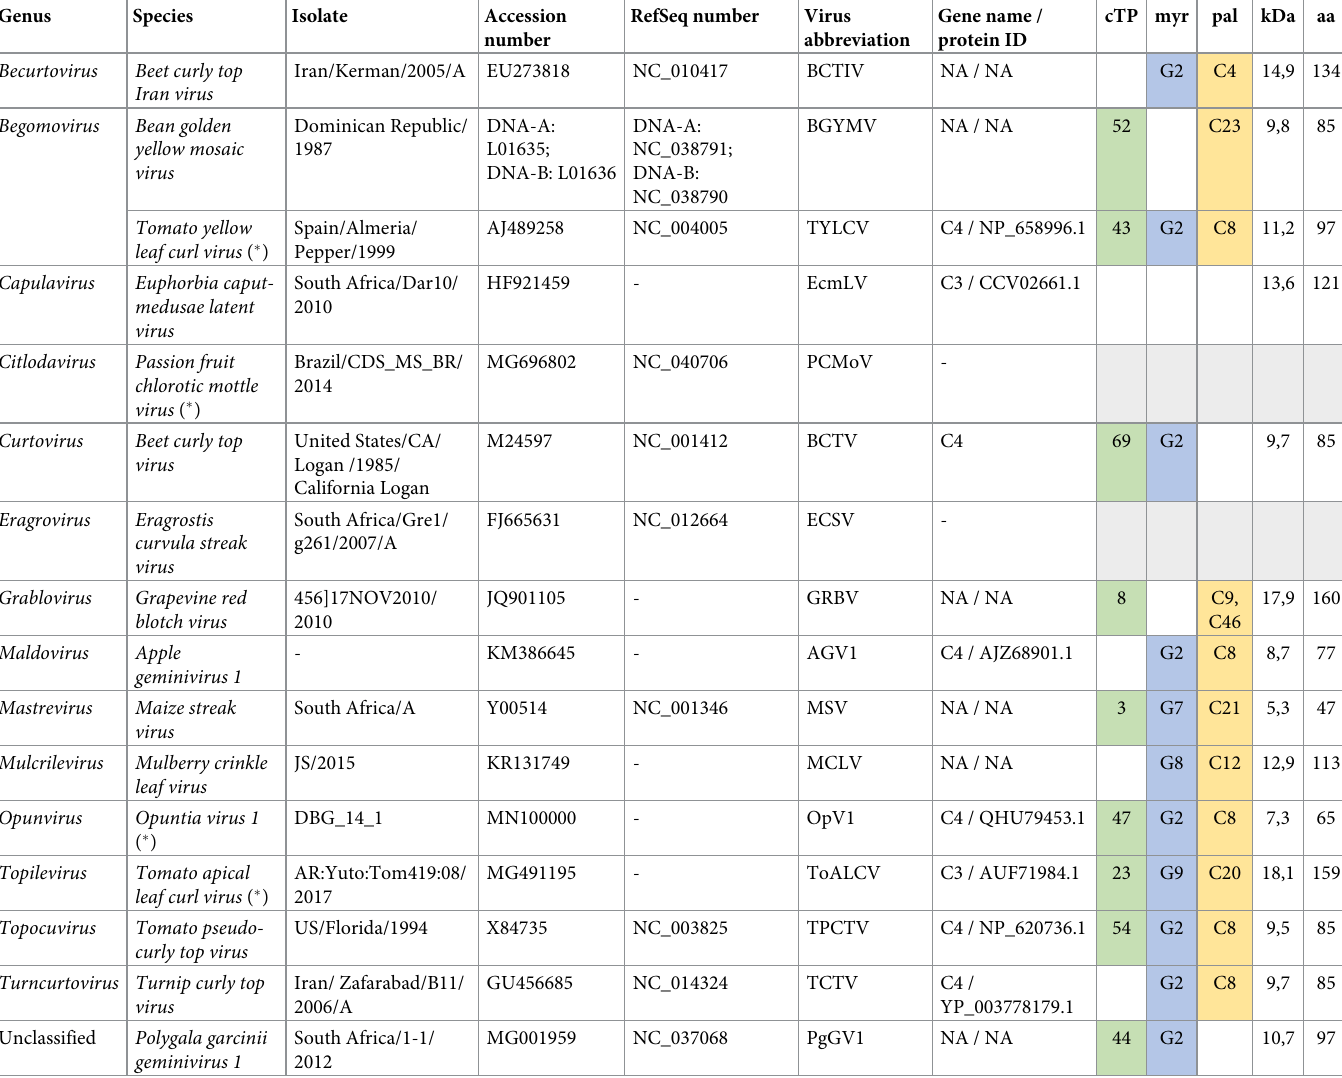
Table 1. Features of the C4 proteins encoded by the type species of the different Geminivirus